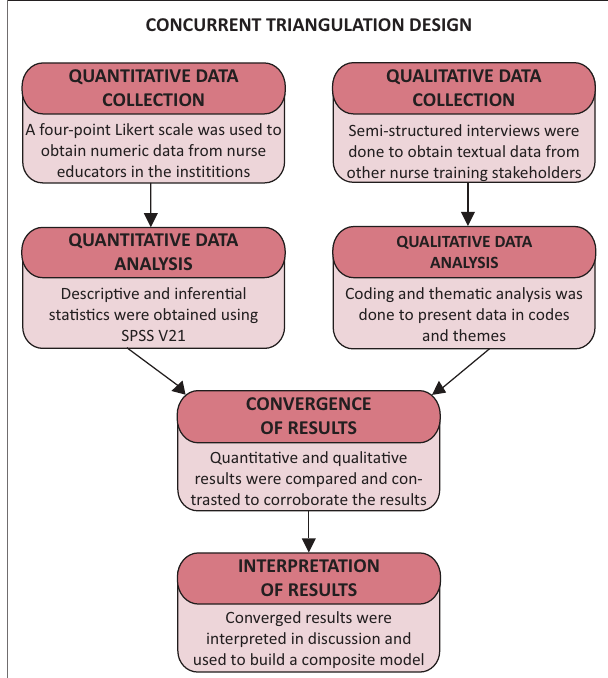
FIGURE 2: The convergence model of triangulation.